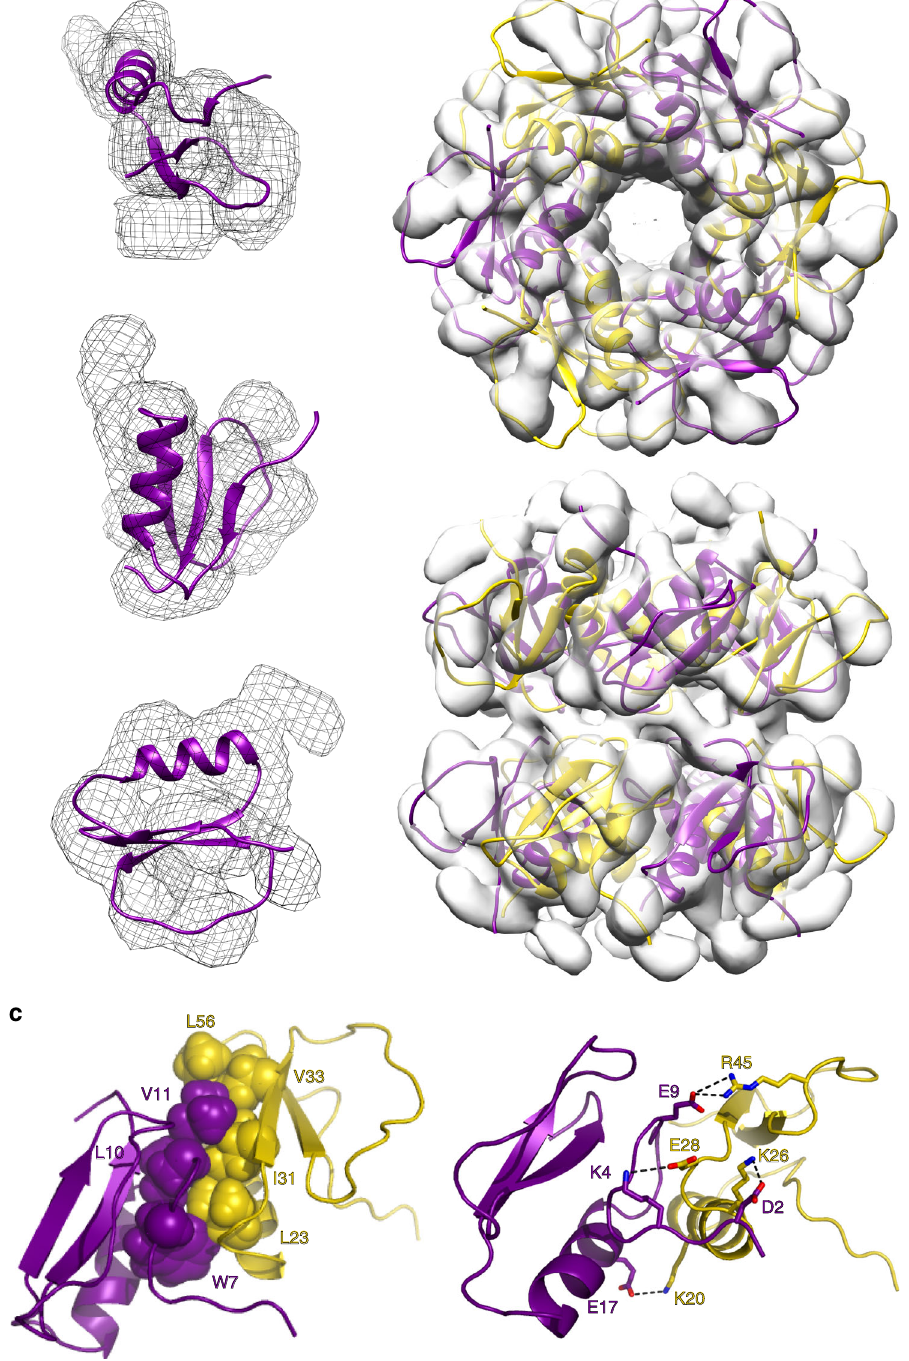
Fig. 6 Structure of the toroidal assembly of fold-switched monomers. a Three views of the fold-switched CI2 eng structure fi tted to the electron density corresponding to one monomer in the cryo-EM 3D reconstruction. b Top and side views of the atomic-resolution structural model of the double-ring assembly of fold-switched CI2 eng monomers (purple and yellow) fi tted into the cryo-EM volume (gray density). c Hydrophobic interface and salt-bridge network between adjacent fold-switched monomers within each ring of the toroidal